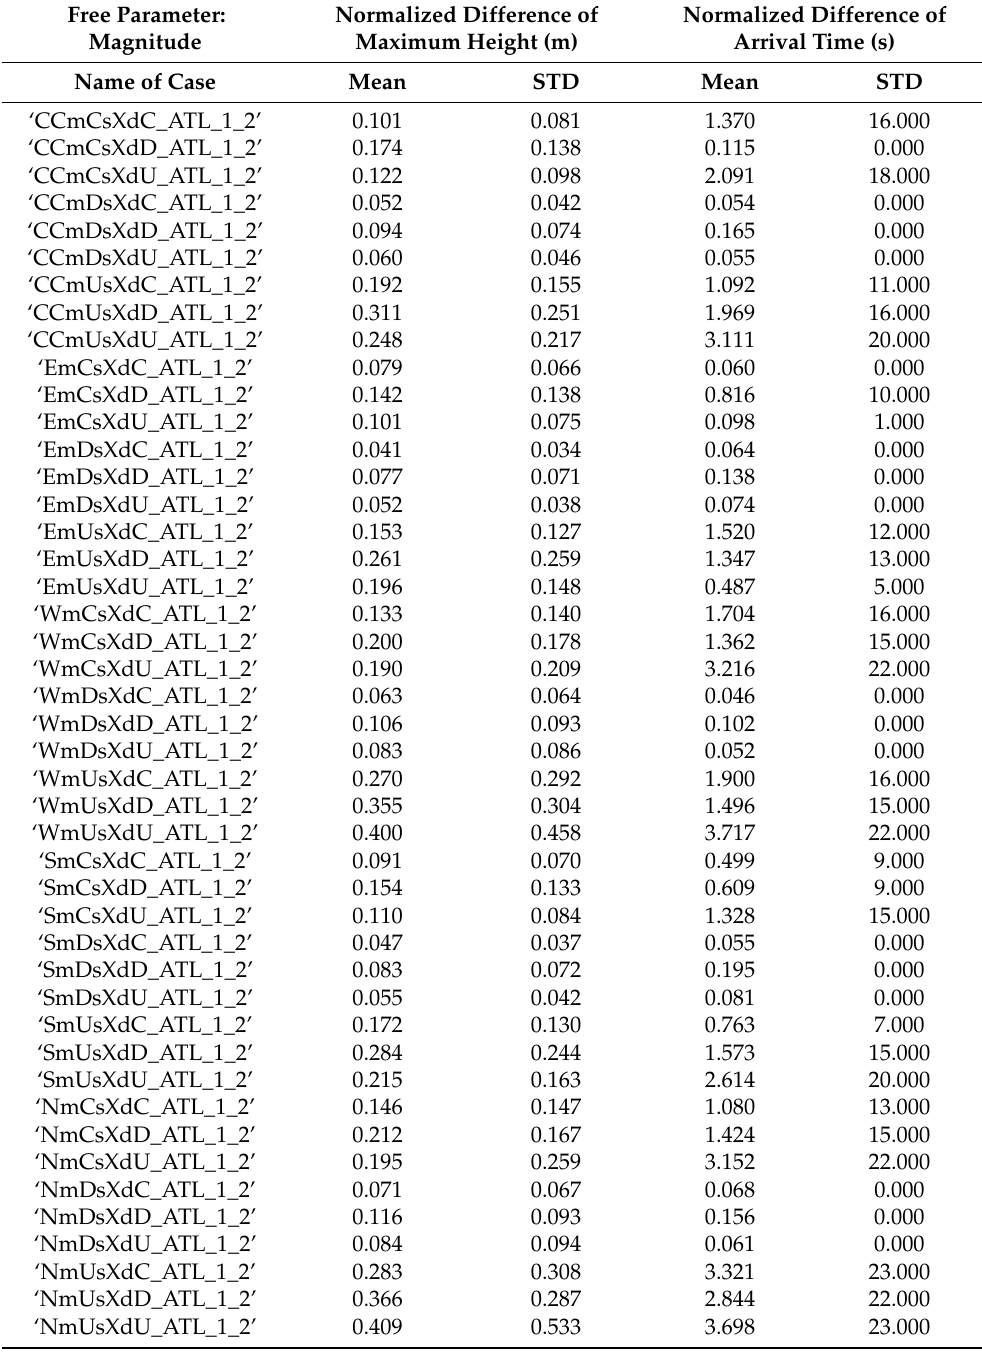
Table A2. Mean normalized difference of maximum height and of arrival time for scenarios with varying